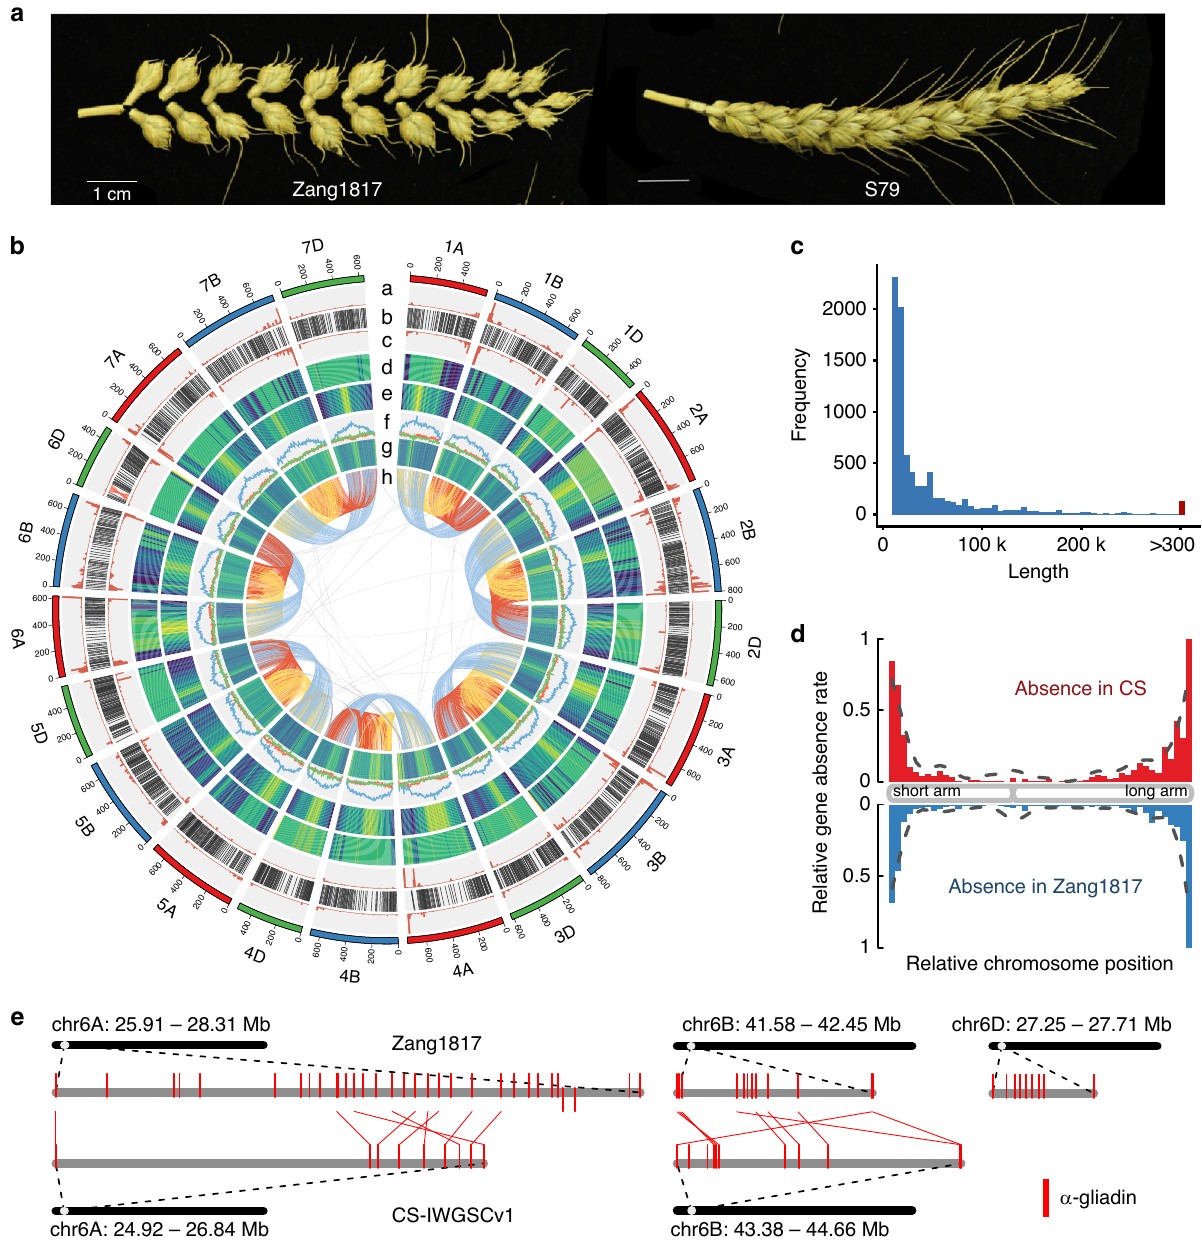
Fig. 1 Phenotypes of Tibetan wheat and overview of the Zang1817 assembly. a Phenotype of rachis brittleness for Tibetan semi-wild wheat Zang1817 and Tibetan wheat landrace S79. b Concentric circle diagram shows distribution of the genomic features of Zang1817: a presence – absence variation (PAV) of genes absent in CS; b collinear gene pairs between CS and Zang1817 (discordant matching regions are marked in red); c PAV genes absent in Zang1817; d density of genomic variations (0 to 240,098 bp per 10 Mb); e density of high-con fi dence genes (HC; 0 – 253 genes per 10 Mb); f transposable element (TE) density in 5-kb windows; g distribution of K-mer frequency; h homeologous gene pairs between subgenomes. c Frequency distribution of PAV segment length (>10kb). d Density distribution of the PAV genes across chromosome model. Red, Zang1817-speci fi c retained genes. Blue, CS-speci fi c retained genes. e Comparison analysis of genomic regions containing α -gliadin genes on group six homeologous chromosomes. Source data underlying Fig. 1c, d are provided as a Source Data fi